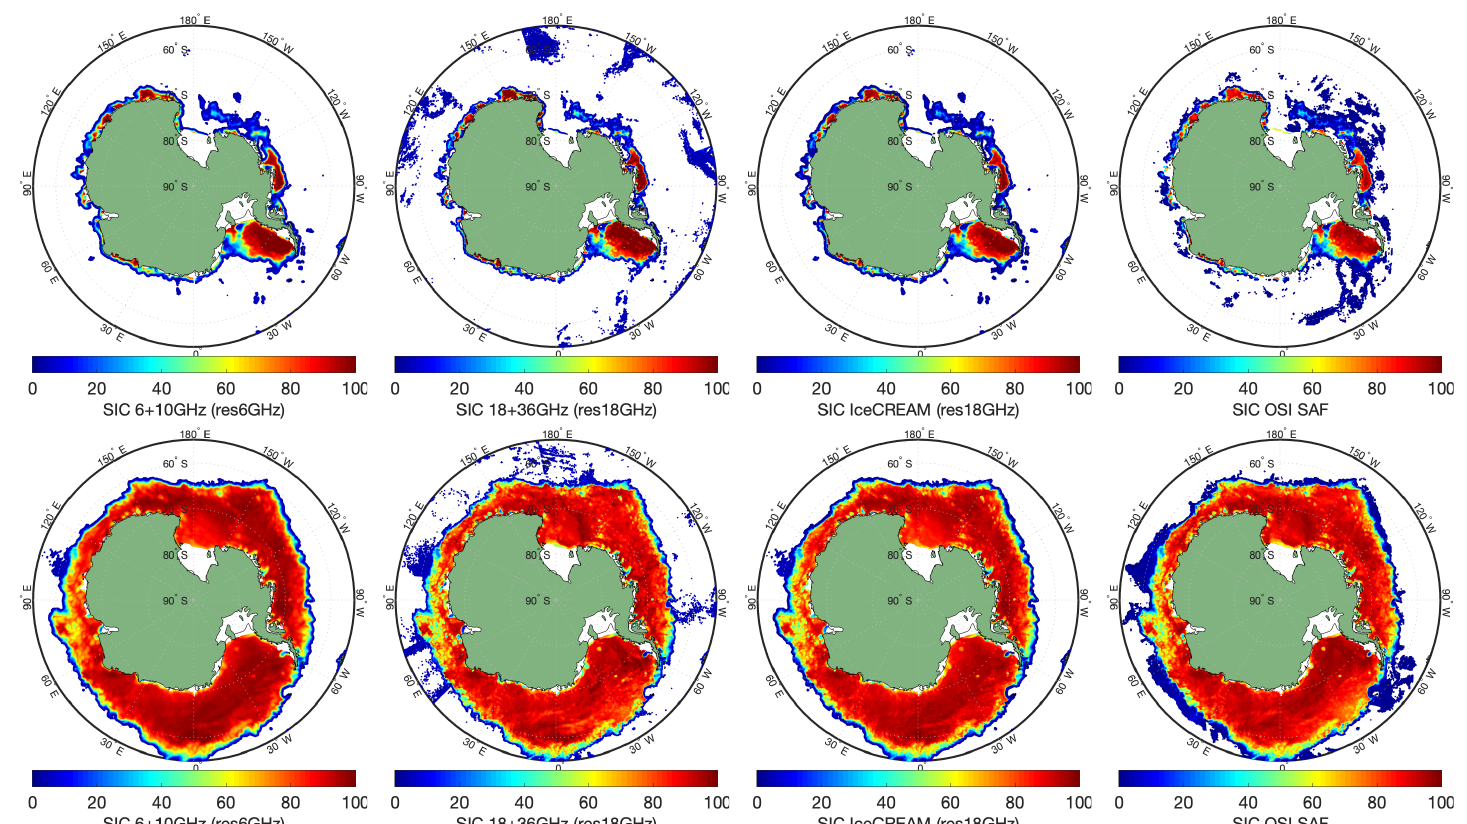
Figure 10. Same as Figure 9, over the south polar